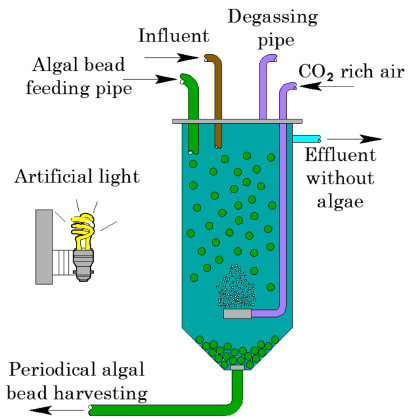
Figure 5. Immobilized algal bead reactor scheme adapted from Ting et al., 2017